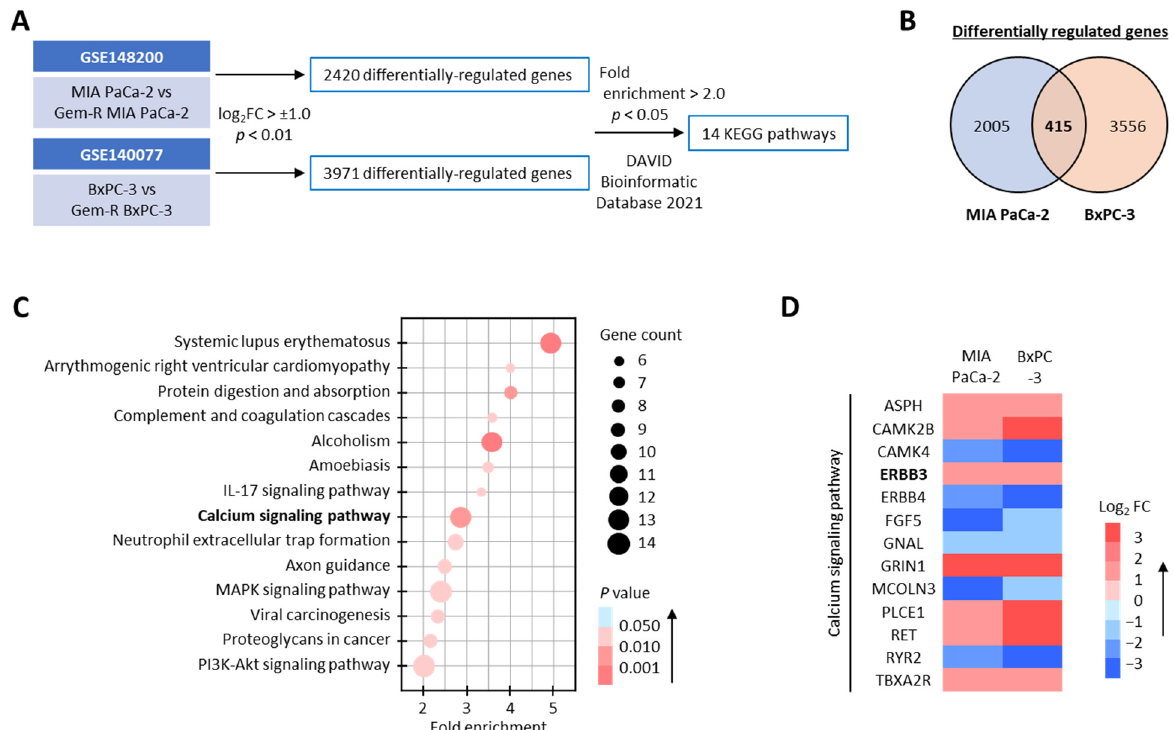
Figure 1. Calcium signaling pathway correlates with Gemcitabine resistance in PDAC cells. ( A ) Schematic illustration of the differentially regulated genes and pathway enrichment discovery analyses in PDAC cells using GSE148200 and GSE140077 datasets. A gene was differentially regulated when it had Log 2 FC > ± 1.0, and p < 0.01, and a pathway was considered enriched when it had fold enrichment > 2.0 and p < 0.05. ( B ) Venn-diagram of differentially regulated genes in PDAC cells. ( C ) Scatter plots of KEGG pathway enrichment analysis of differentially regulated genes in Gem-R PDAC cells. The circle area indicates the number of differentially regulated genes in the pathway, and the circle color represents the p value range. ( D ) Heatmap of differentially regulated genes in the calcium signaling pathway. PDAC, pancreatic ductal adenocarcinoma; Gem-R, Gemcitabine-resistant; FC, fold-change; KEGG, Kyoto Encyclopedia of Genes and